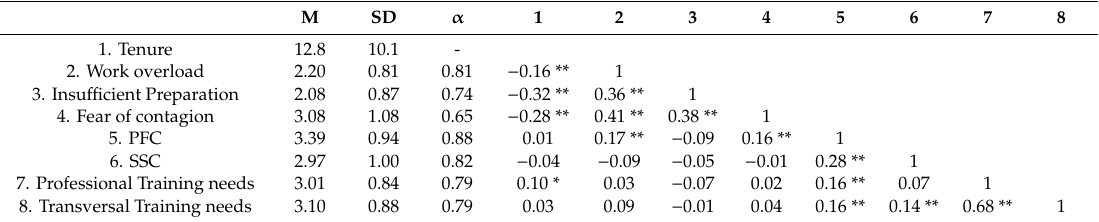
Table 1. Means, standard deviations, Cronbach’s alpha, and Pearson correlations ( N = 403). M SD α